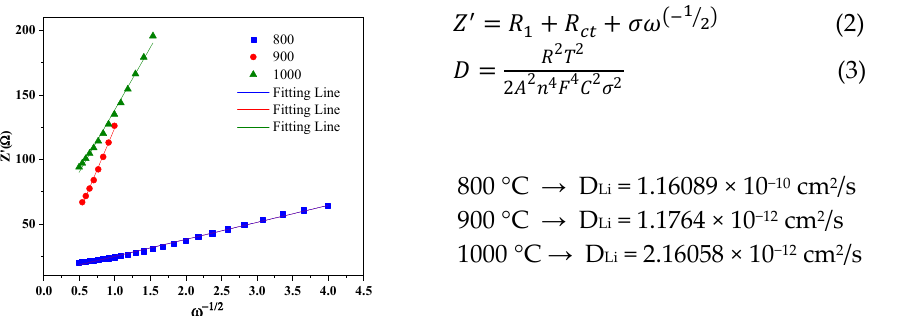
concentration of Li-ion in an active material.